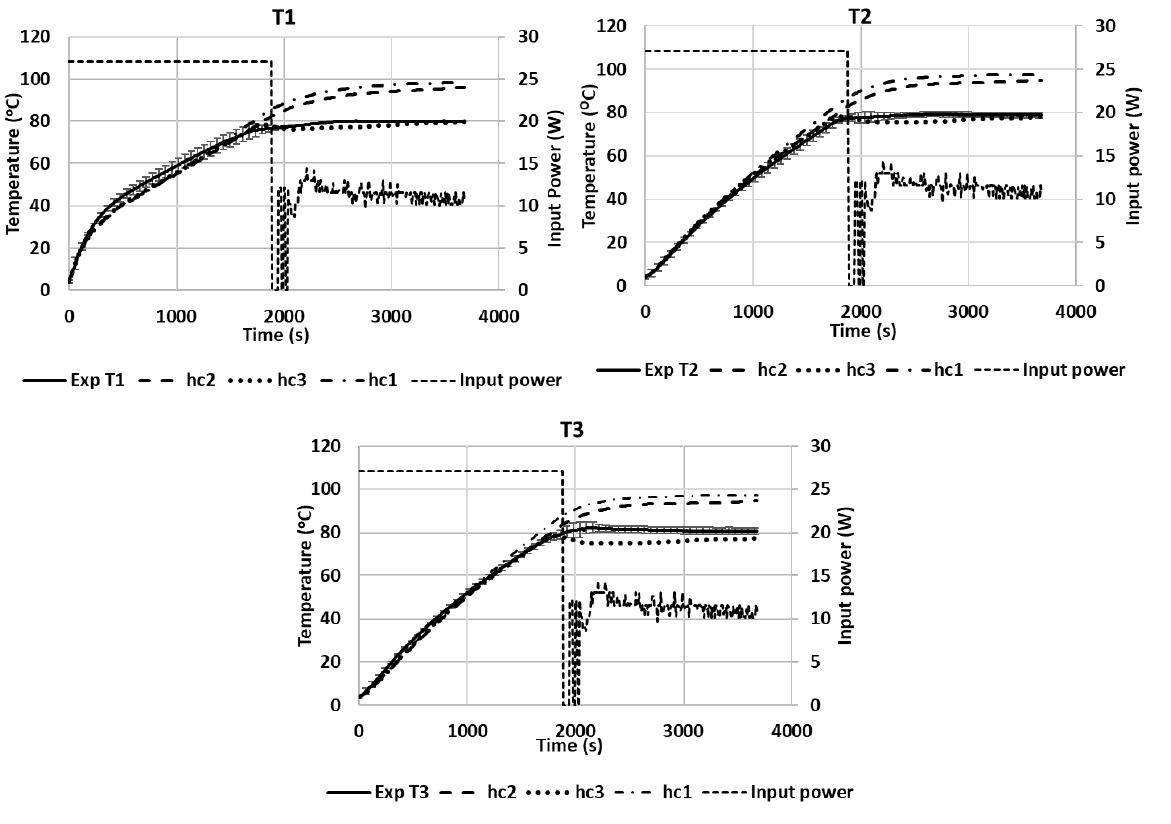
Figure 11. Temperature profiles of three points inside the pâté sample during microwave heating at positions A (Exp) compared with simulations.